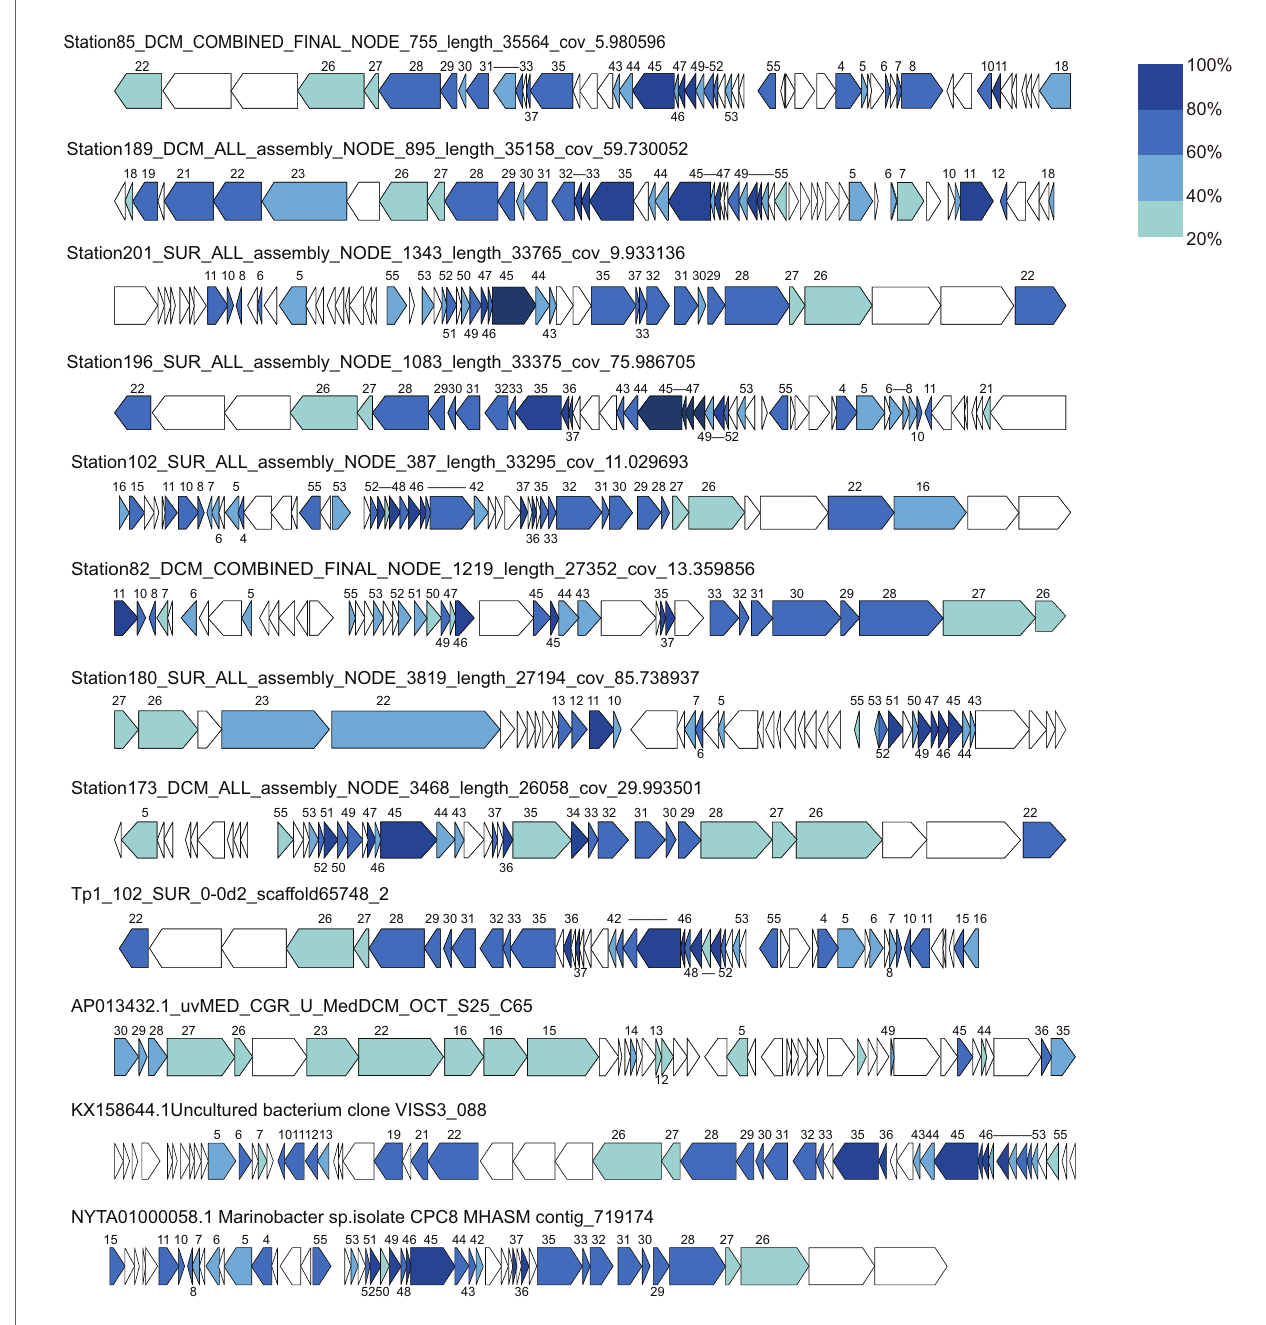
Two genes involved in DNA cleavage have been identified including the crossover junction endodeoxyribonuclease RusA gene (ORF51, PF05866) and the predicted endonuclease gene (ORF20). Both gene products are predicted to cut the phosphodiester bonds between nucleotides in the interior DNA helix, resulting in the production of nucleotide monomers.